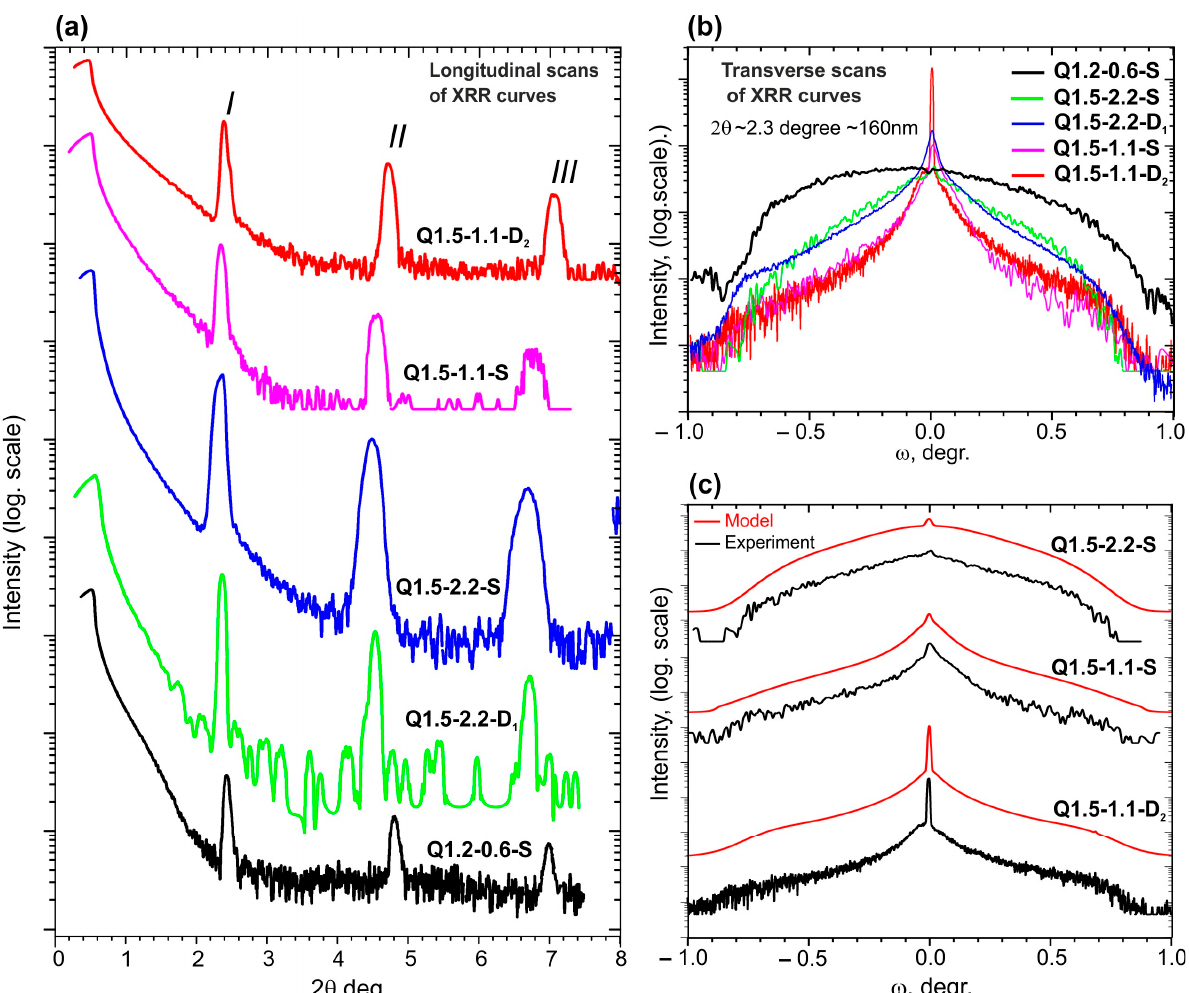
Figure 6. ( a ) X-ray reflectivity curves of 400×{GaN m /AlN 16 } ( m = 1.2, 1.5) MQW structures; ( b ) ω scans of the first Bragg-like peaks of the 400×{GaN m /AlN 16 } ( m = 1.2, 1.5) MQW structures. ( c ) Experimental (black) and simulated (red) ω scans of the first Bragg-like peaks of 400 × {GaN 1.5 /AlN 16 } MQW struc- tures.